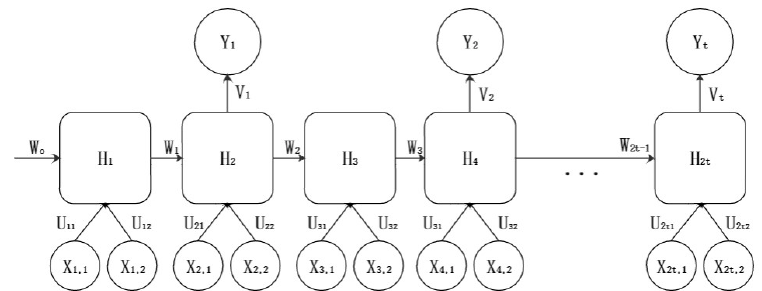
Figure 4. The structure of RNN prediction model.